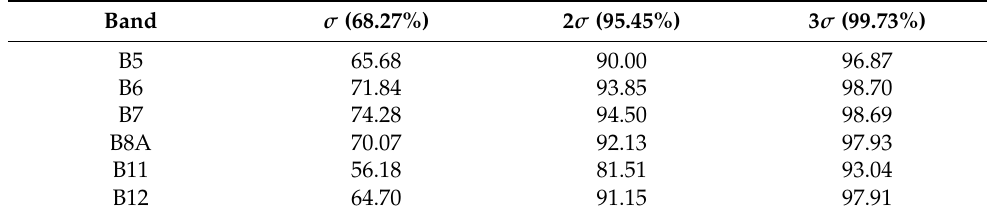
Table 14. Probability of the absolute error being lower than n × σ